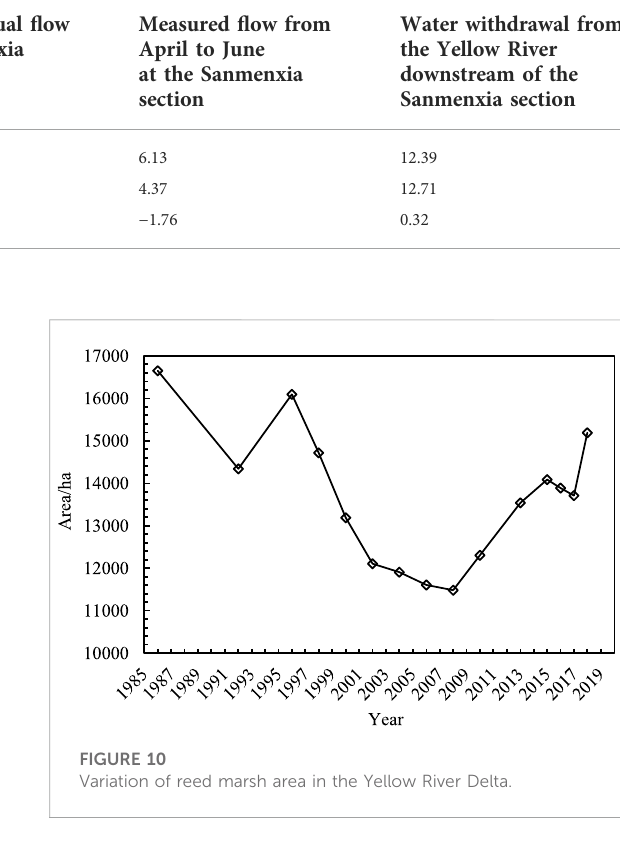
TABLE 4 Change in water in fl ow and water withdrawal of the Yellow River (billion m³).